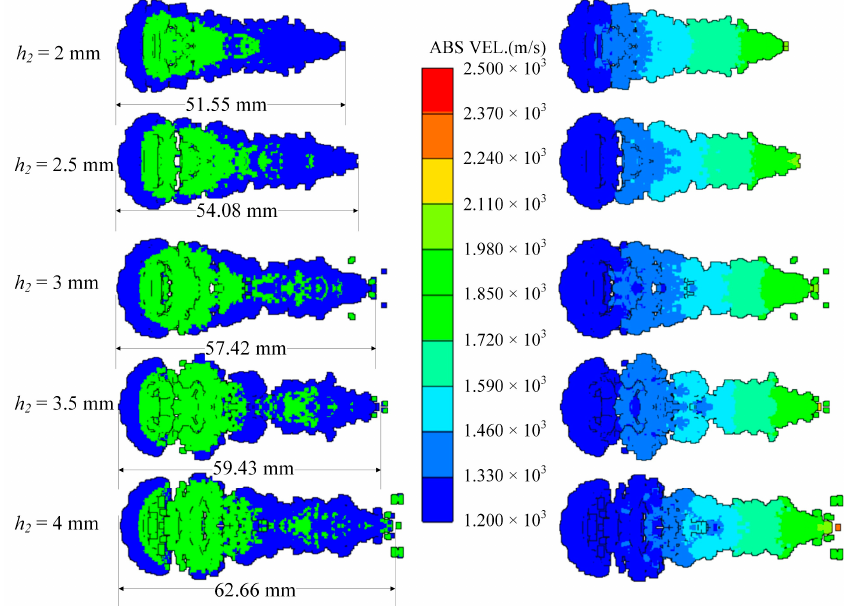
Figure 14. Coating shapes and velocity distribution as the thickness of the reactive liner changes.